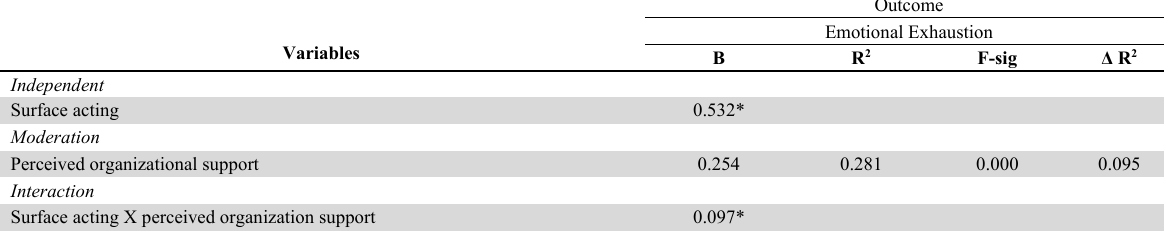
Moderation effect of perceived organizational support on surface acting and emotional exhaustion